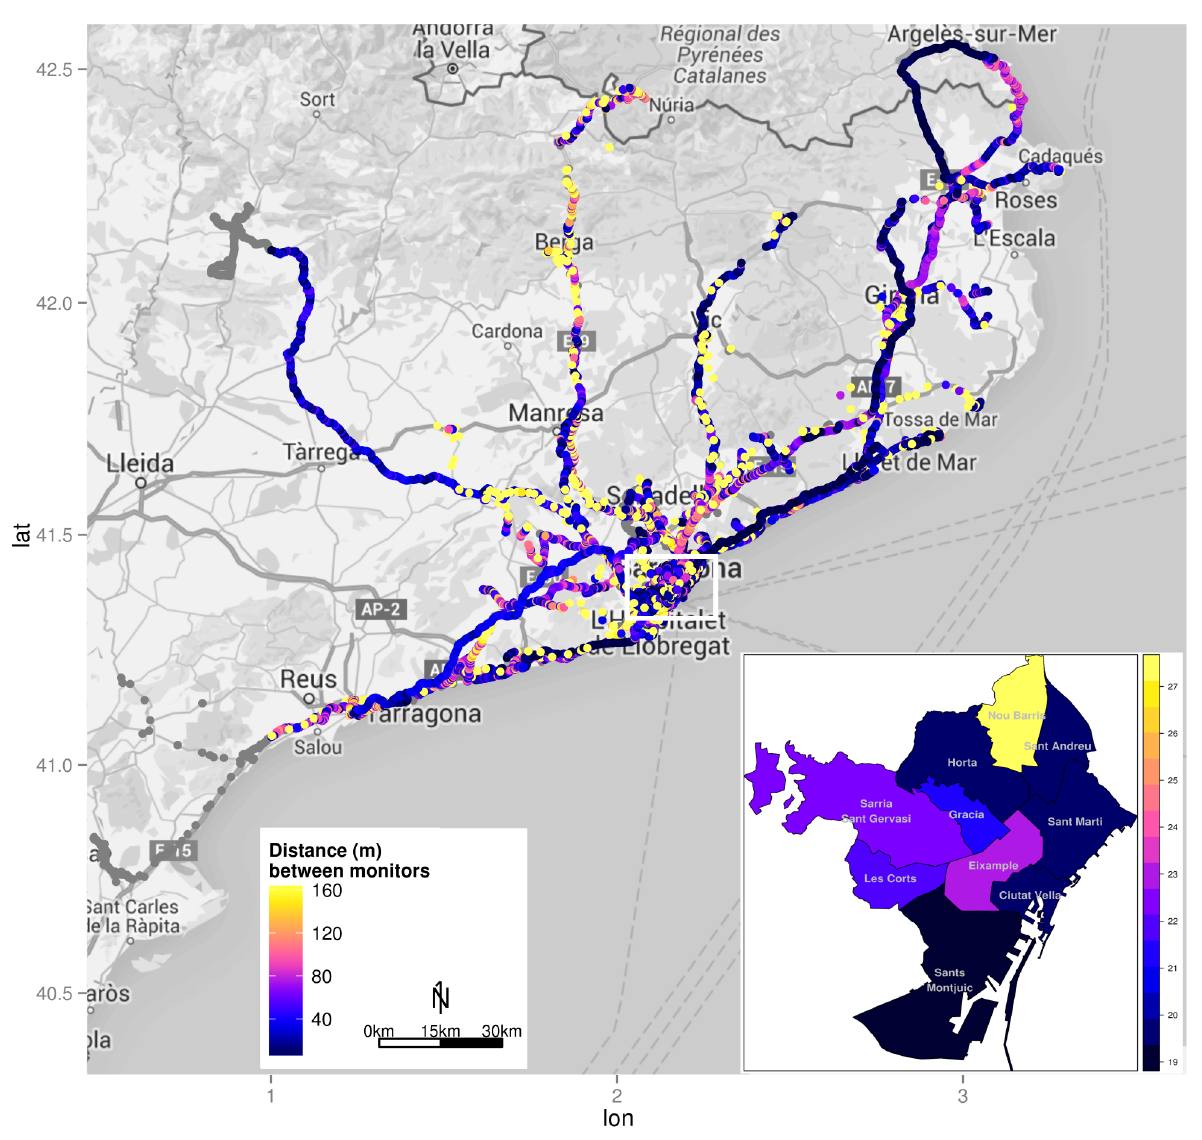
Figure 1. Catalonia street map and Barcelona district map with the spatial distribution of the mobile phone tracking accuracy among the 986 person-days monitored. Gray points represent those locations without concomitant locations from Global Positioning System (GPS) tracker to estimate accuracy. In the district map of Barcelona (inset), the median geolocation accuracy of the mobile phone is shown in the 10 districts of Barcelona